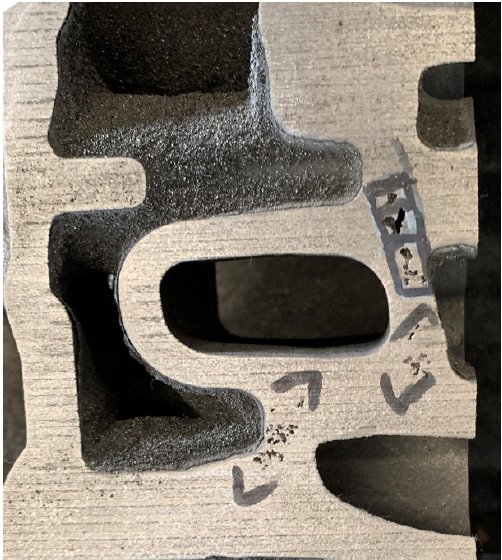
Figure 1. Shrinkage defects in the actual casting with modulus of 0.6.